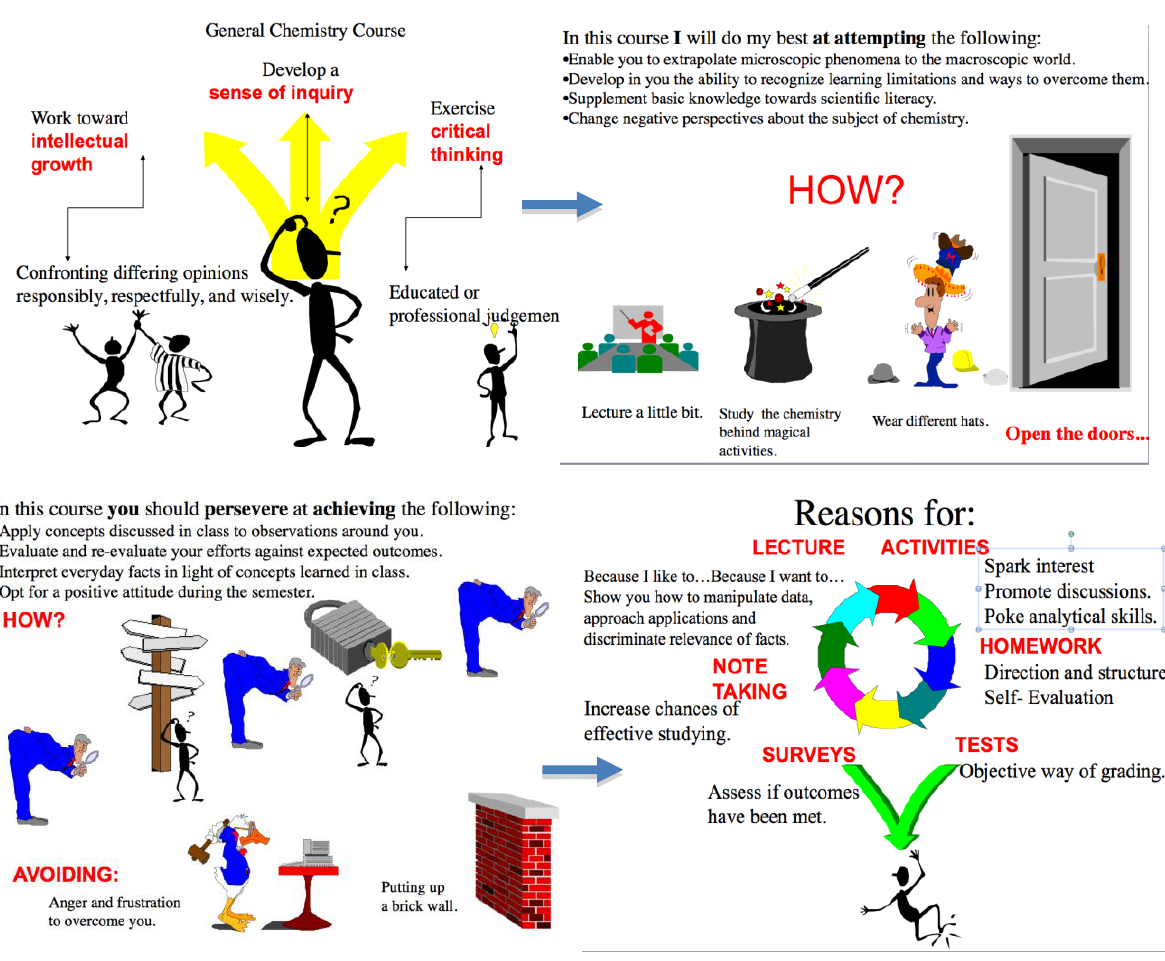
Fig.3. Sequence of slides used to discuss the class